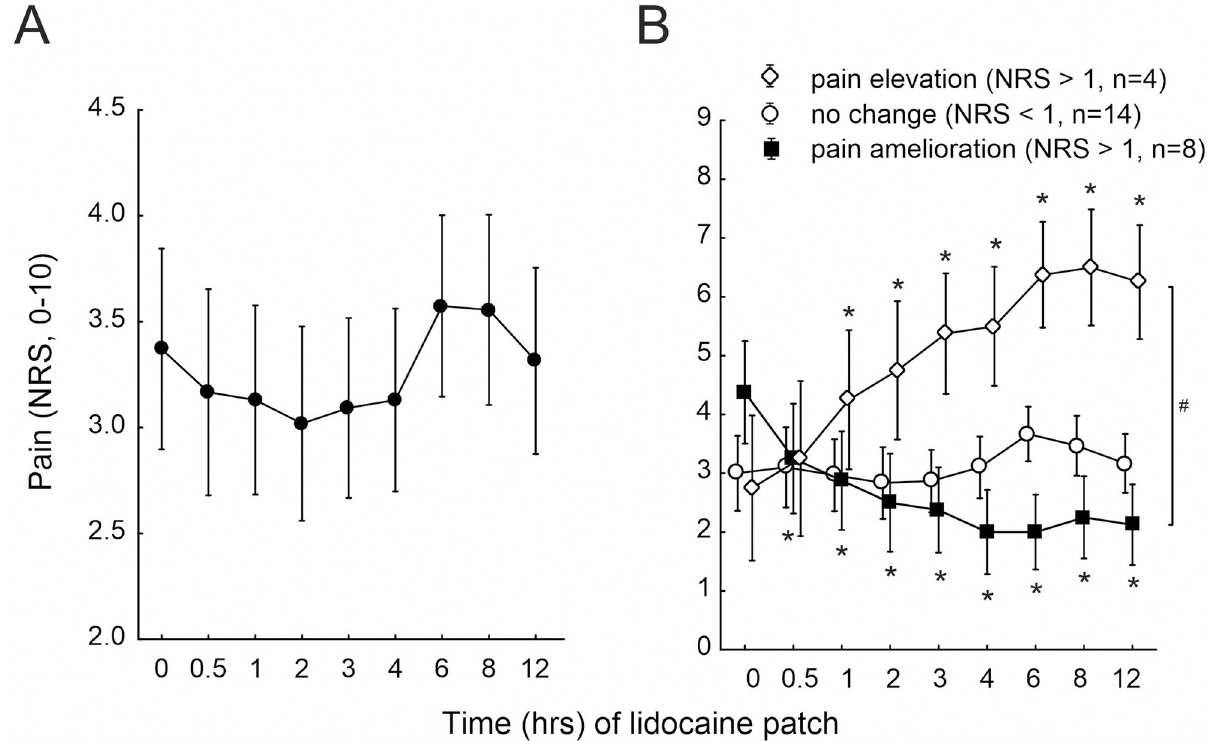
Fig 3. Pain in response to topical lidocaine. (A) Evaluation of acute (spontaneous) pain (NRS, 0–10) of 27 patients at the time of visit (t = 0) and upon a lidocaine 5% patch applied to the assessed neuropathic skin site at 0.5–12 hours after application. (B) Acute (spontaneous) pain (NRS, 0–10) at the time of investigation (t 0) and in response to a lidocaine 5% patch at 0.5–12 hours after application in patients that reported a pain reduction exceeding NRS 1 compared to t 0 (“pain amelioration”, solid squares), pain enhancement of t 0 exceeding NRS 1 (“pain elevation”, open diamonds), and patients without lidocaine effect on t 0 (NRS changes– 1 to 1, open circles). Hash symbol indicates significant differences between the patients’ group (p < 0.0001, ANOVA) and asterisks indicate significance compared to t 0 acute (spontaneous) pain (p < 0.05, Fisher’s Least